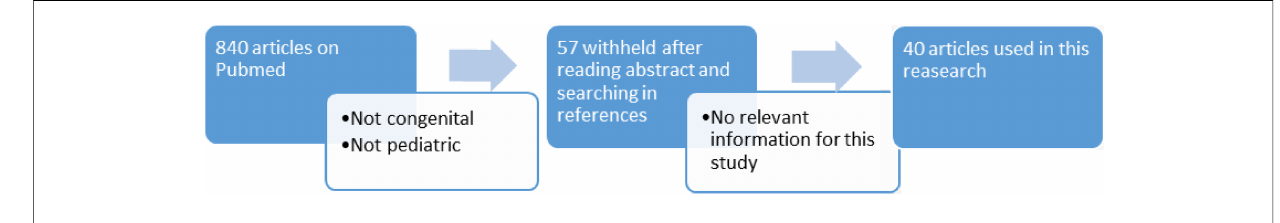
FIGURE 1 Literature search, article